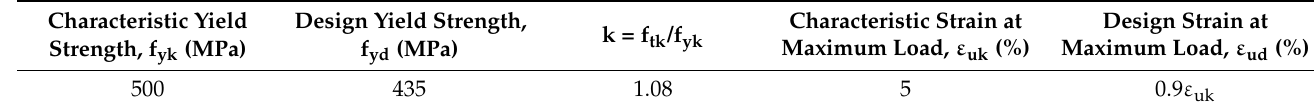
Table 4. Properties of reinforcement in Figure 12.